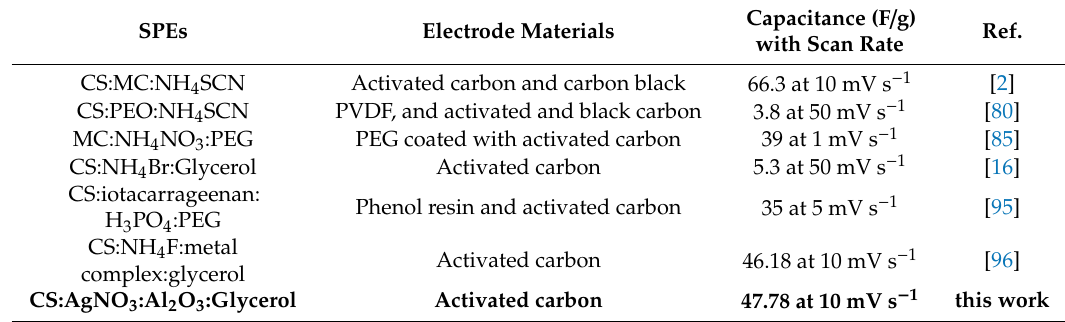
Table 5. The capacitance value of electrochemical double-layer capacitors (EDLCs) using various solid polymer electrolyte (SPE) studies as